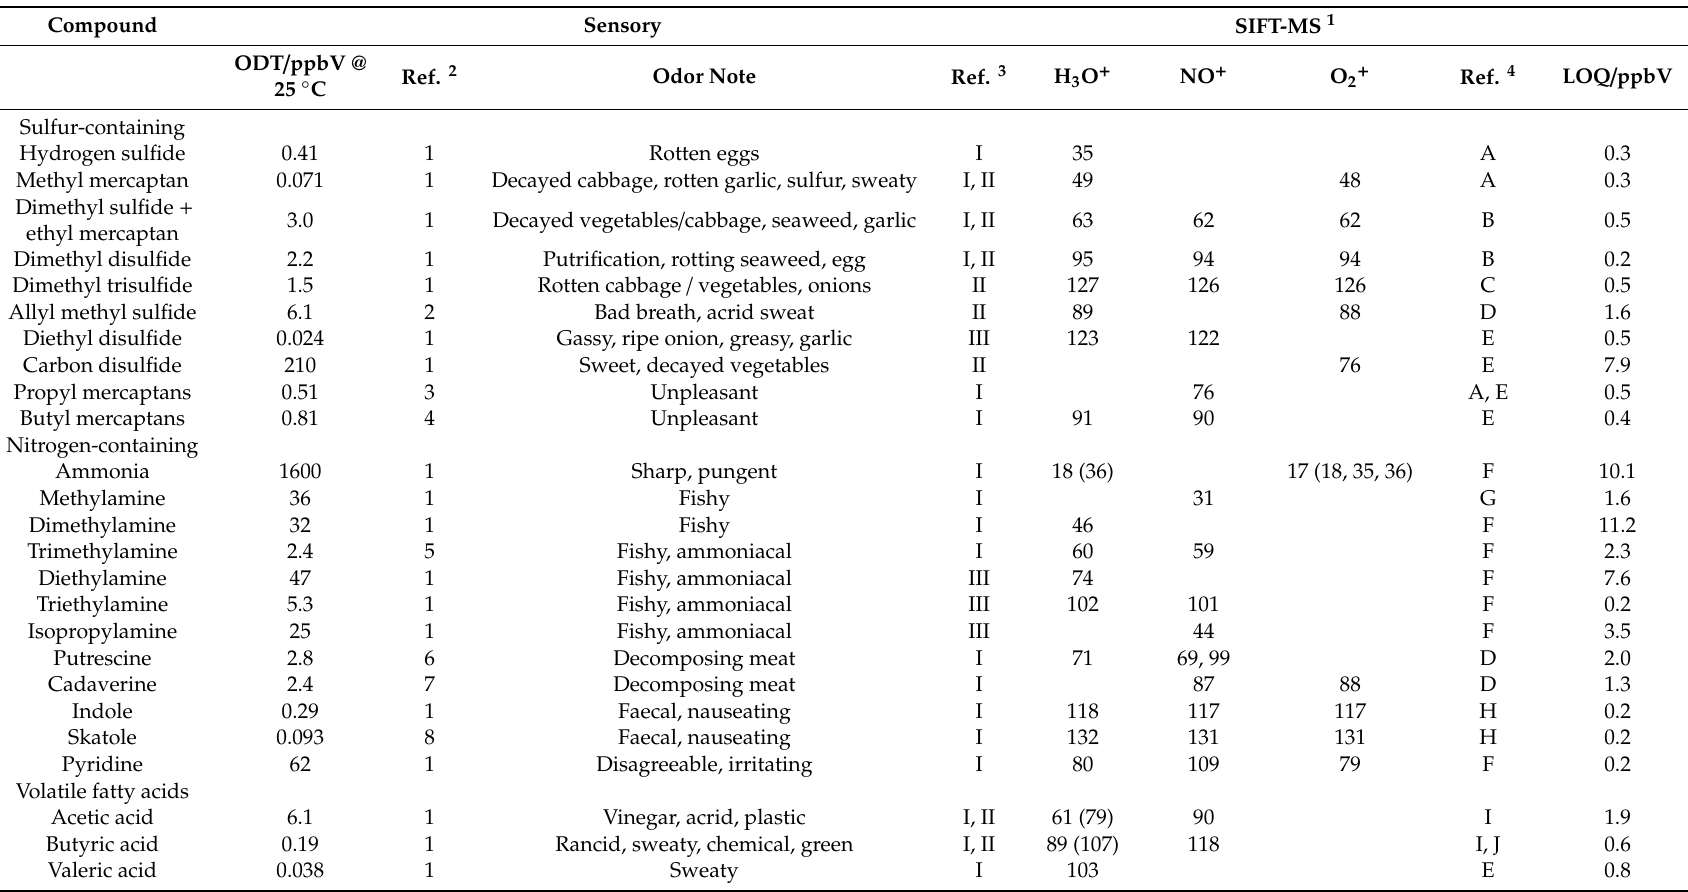
Table 4. Target compounds for SIFT-MS analysis, together with published odor detection thresholds (ODTs) and odor notes. Reagent ions and primary product ions mass-to charge ratios (in Daltons) used to quantify target compounds, with secondary (water cluster) ions shown in parentheses. To avoid unnecessary complications, not all ion products of each volatile are shown. More details are given in the